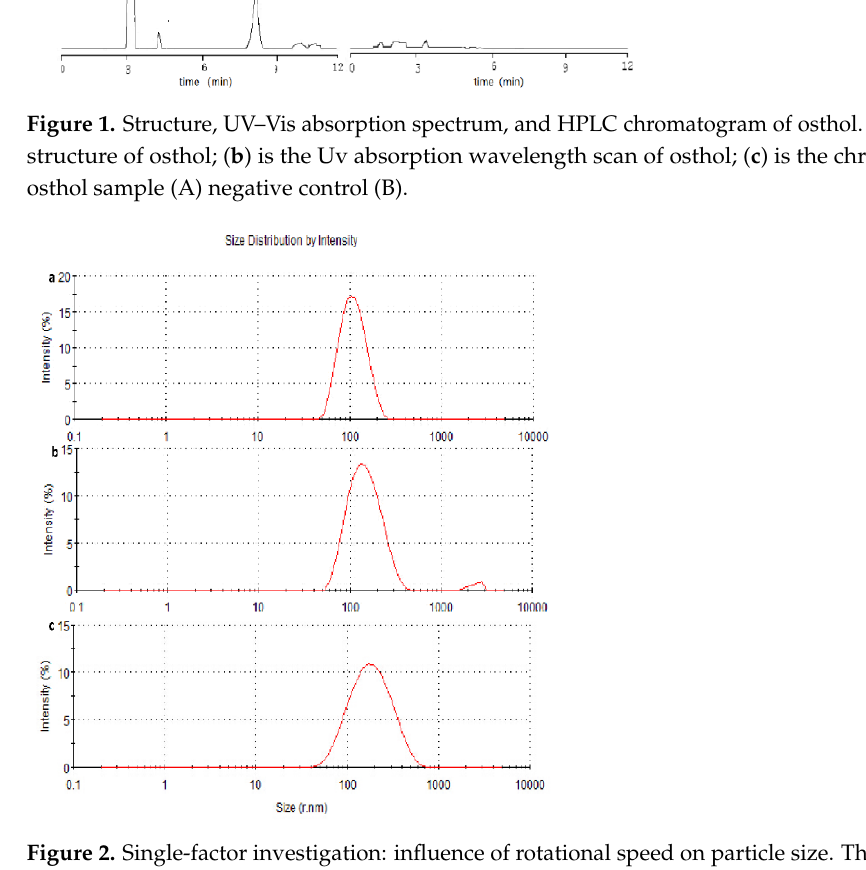
Figure 1. Structure, UV – Vis absorption spectrum, and HPLC chromatogram of osthol. ( a ) is chemi- cal structure of osthol; ( b ) is the Uv absorption wavelength scan of osthol; ( c ) is the chromatogram of osthol sample (A) negative control (B).